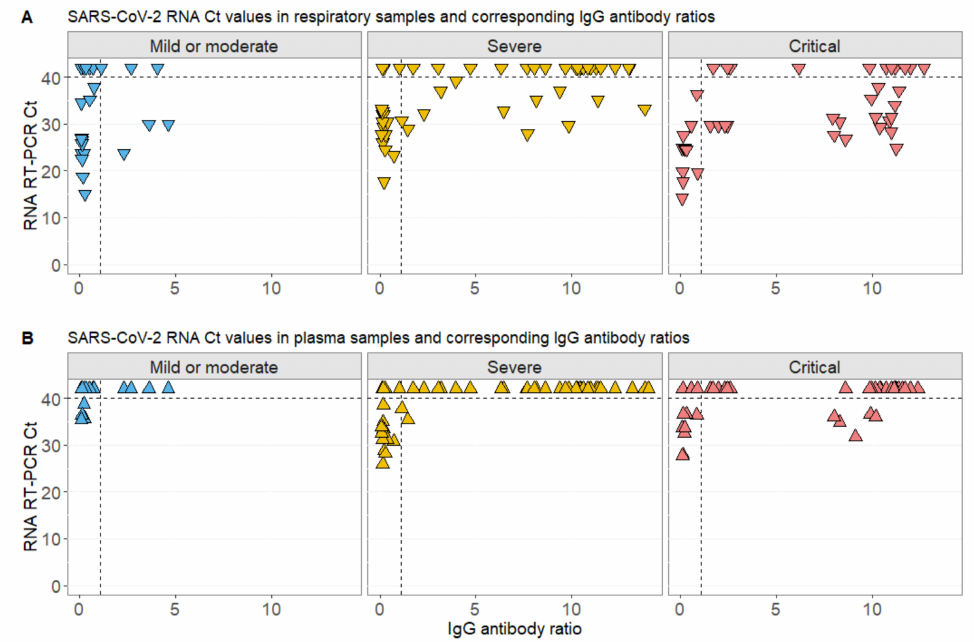
Figure 3. SARS-CoV-2 Ct values in relation to IgG ratios according to COVID-19 severity. ( A ) Relation of SARS-CoV-2 respiratory Ct values with IgG values at the same day ± 2 days; ( B ) relation of SARS-CoV-2 plasma Ct values with IgG values at the same day ± 2 days in patients with mild or moderate, severe, or critical COVID-19 disease severity. Negative PCR results are displayed above the detection Ct of 40. Dashed horizontal lines display the detection threshold of SARS-CoV-2 RNA Ct values and the antibody cut-o ff of seroconversion for the assay